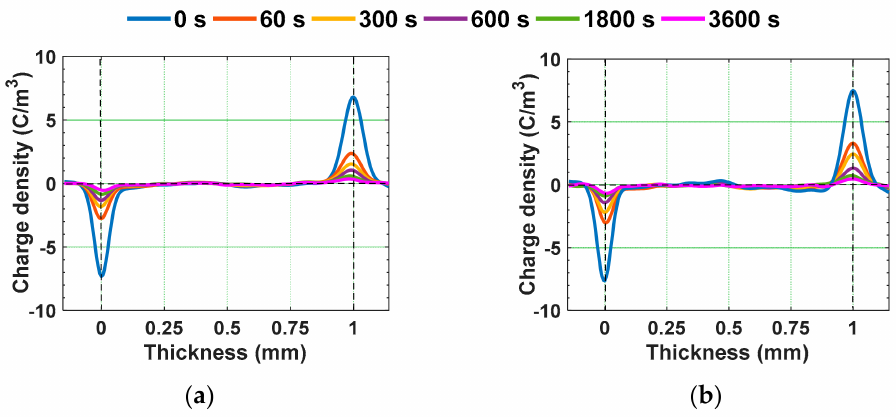
Figure 7. Space charge distribution during depoling of ( a ) unaged and ( b ) 8 kGy gamma irradiated epoxy micro-nano composites after reduction of 10 kV positive DC voltage